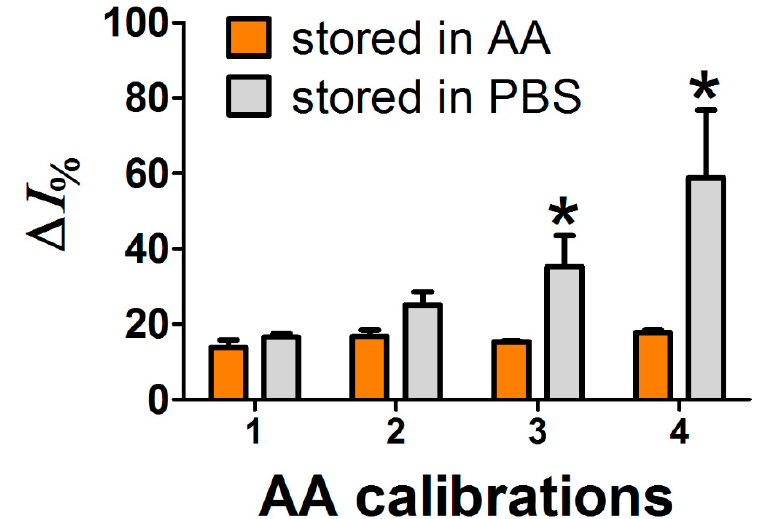
Figure 3. Δ I % calculated from four calibrations of ascorbic acid (AA) are reported for two groups of sensors treated with Chemiplus 2DS HB stored in presence of AA (orange columns) or in phosphate buffer (grey columns); the AA calibrations consisted of single 1 mM AA injections into the electro-analytical cell containing a group (n = 3) of sensors; After each calibration, sensors were washed in distilled water and stored into solutions of PBS or AA with an applied potential of +700 mV until next calibration. Δ I % is the current difference pre- and post- injection of AA reported to Δ I of bare electrode as mathematically described in statistical analysis section of material and methods. * means a statistically significant difference ( p < 0.01).